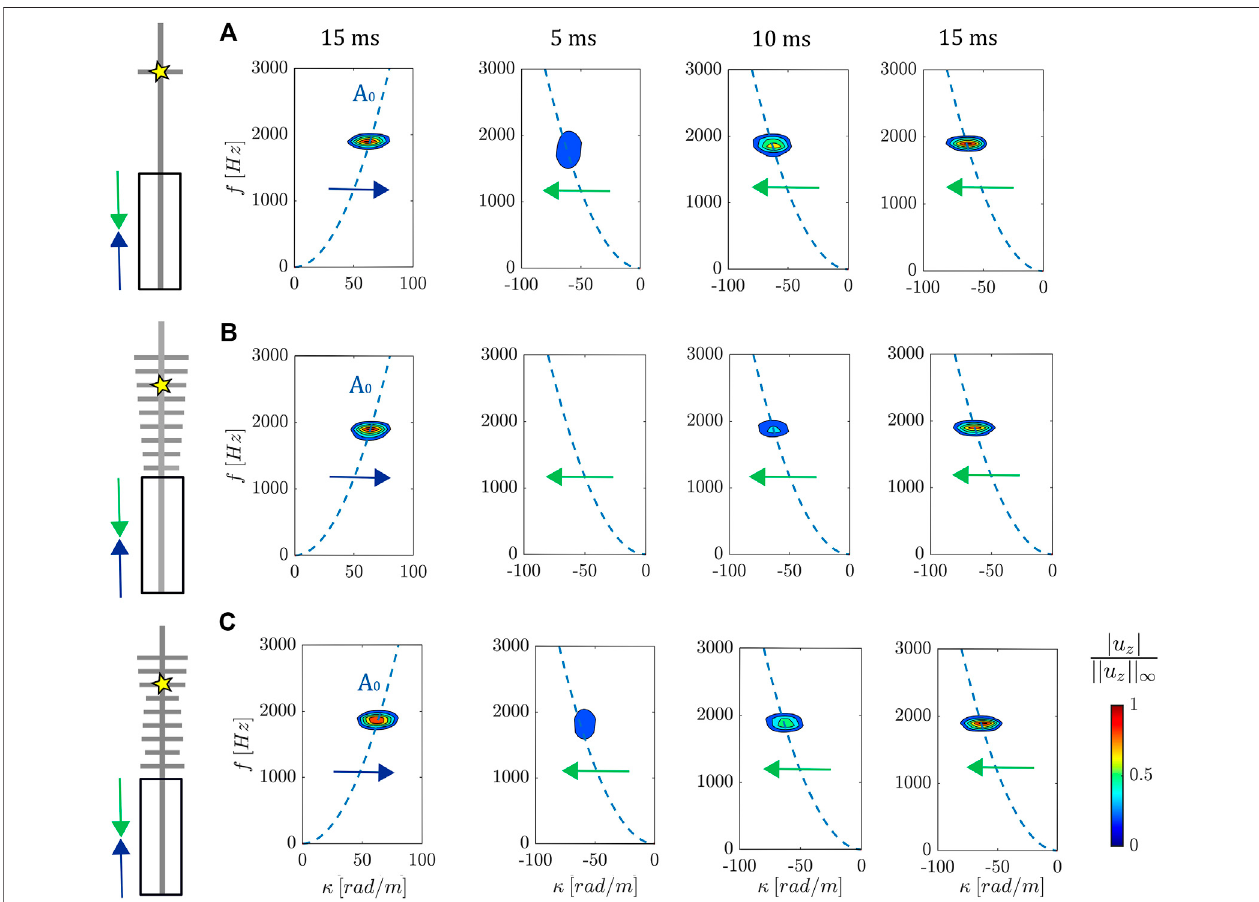
FIGURE5| ExperimentalFastFourierTransform(FFT)ofthewave fi eldmeasuredontheplainbeamforthelonecell (A) ,linear (B) andrandomarray (C) .Wavesare backscattered when the input A 0 wave reaches the target cell marked with the yellow star. Since the linear graded array (B) provides a smooth reduction of the wave group velocity, it shows lower re fl ections with respect to the other two cases (A, C) . While this effect is notably marked at small time increments (e.g. 5 and 10 ms ), it slowly vanishes in time (e.g. 15 ms ), con fi rming the inherently re fl ective properties of the system.